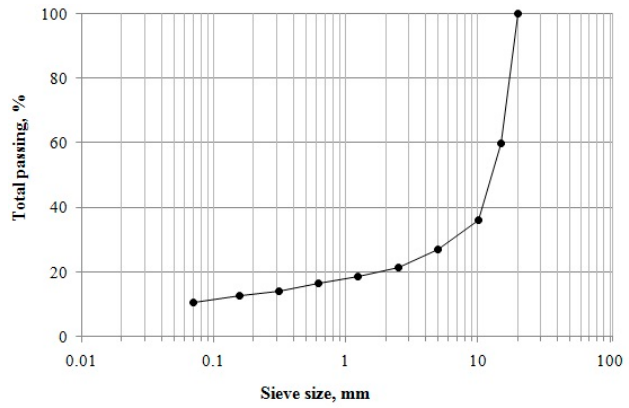
Table 4. Mix design characteristics of the stone mastic concretes.